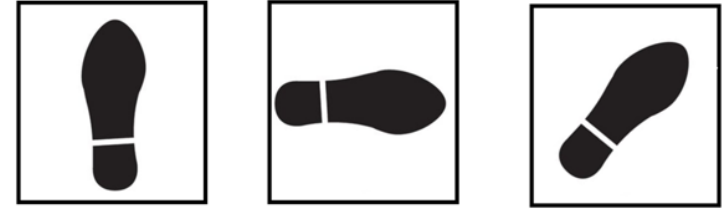
Figure 7. Step positions. 1st Position ( left ); 2nd Position ( center ); and 3rd Position ( right ).